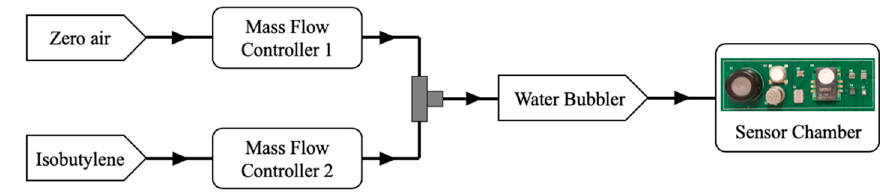
Figure 7. Experimental gas-rig set-up for testing isobutylene concentrations.